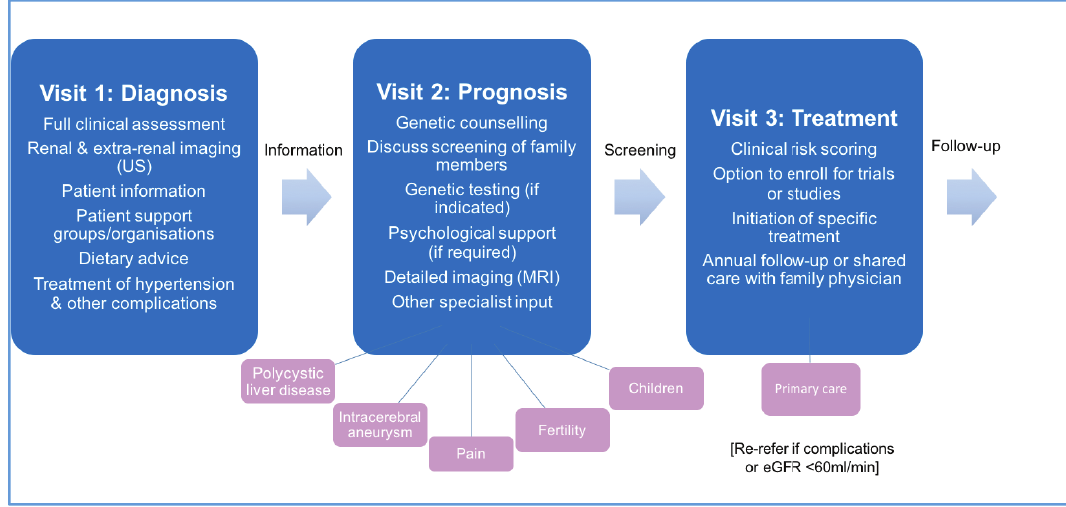
Figure 4. A recommended multidisciplinary stepped pathway for managing patients with autosomal dominant polycystic kidney disease. For simplicity, this has been drawn as a linear follow-up pathway with the major emphasis being on diagnosis, prognosis and treatment at sequential visits. A shared care model with primary care physicians after full evaluation is complete and no treatment planned is an option in nationally funded systems. eGFR, estimated glomerular filtration rate; MRI, magnetic resonance imaging; US, ultrasound.